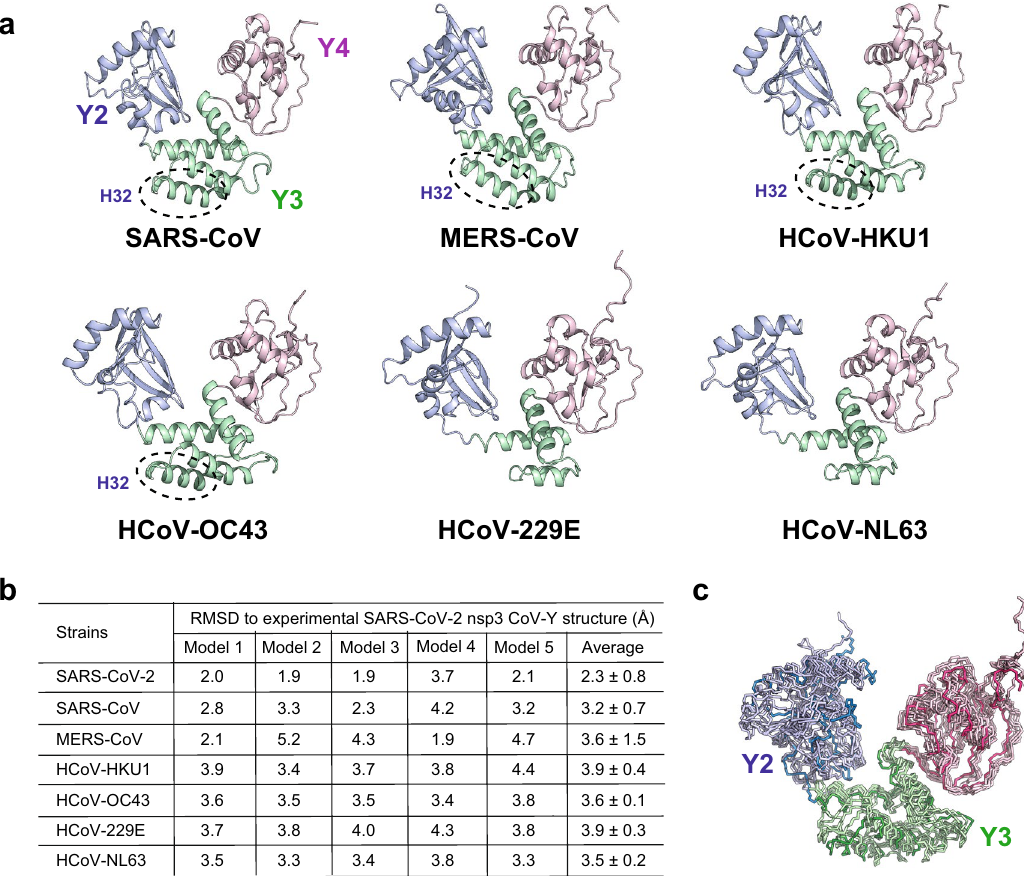
Figure 4. Structural conservation among nsp3 CoV-Y homologs. ( a ) Ribbon diagrams of the top-ranked AlphaFold-computed structural models of the nsp3 CoV-Y domains for four human Betacoronaviruses (SARS- CoV, MERS-CoV, HCoV-HKU1 and HCoV-OC43) and two human Alphacoronaviruses (HCoV-229E and HCoV-NL63). Dashed ellipse indicates the H32 helix of Y3 on the Betacoronaviruses that is presumably lacking in Alphacoronavirus CoV-Y. ( b ) The RMSDs of the five top-scored models calculated using AlphaFold 36 to the crystal structure of the SARS-CoV-2 nsp3 CoV-Y. ( c ) Superposition of the crystal structure and six structural models of the CoV-Y